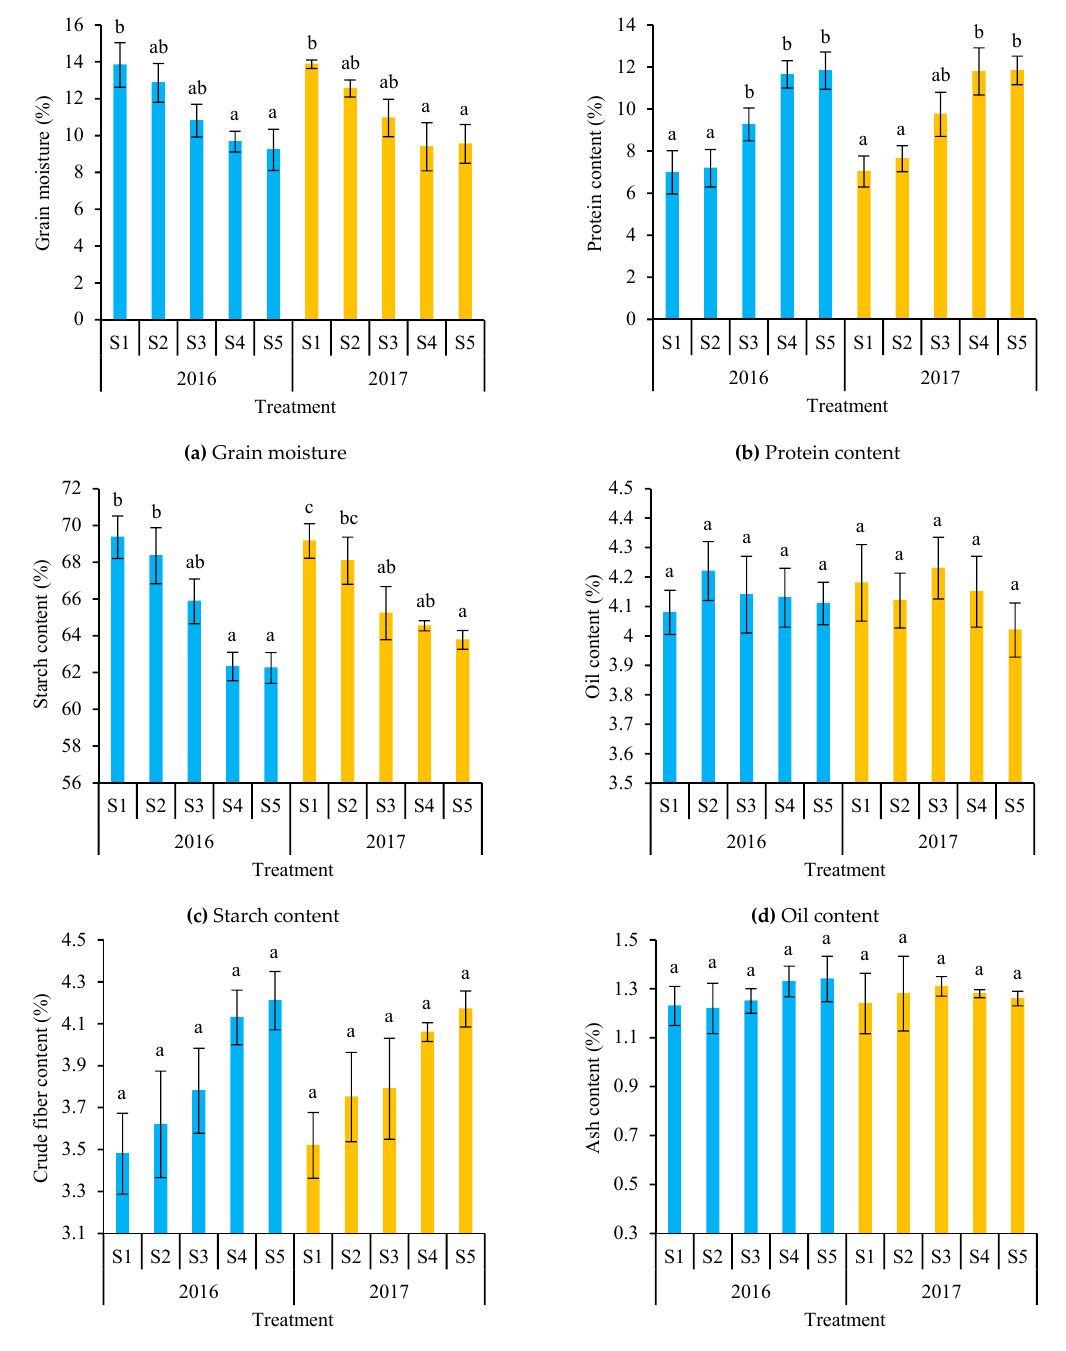
Figure 7. The grain quality of maize in 2016 and 2017. Note: The same letter above the error bars in same year represents no significantly different at p ≤ 0.05.